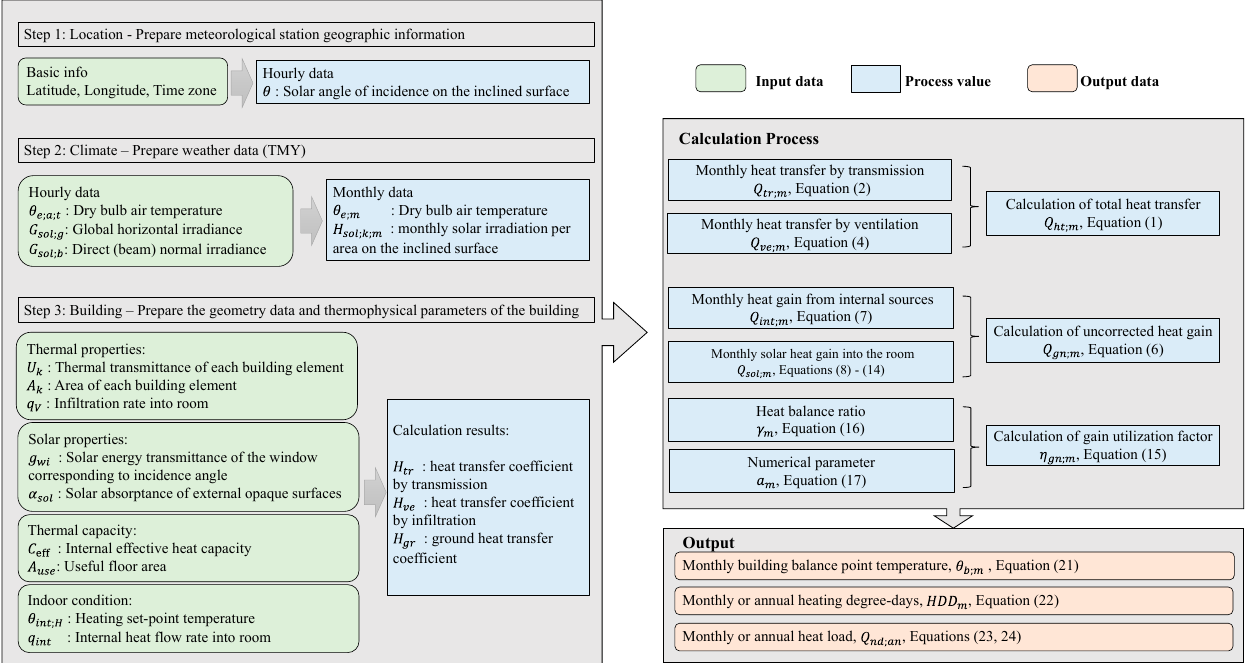
Figure 2. Calculation procedure of building energy simulation software BPT V1.0.